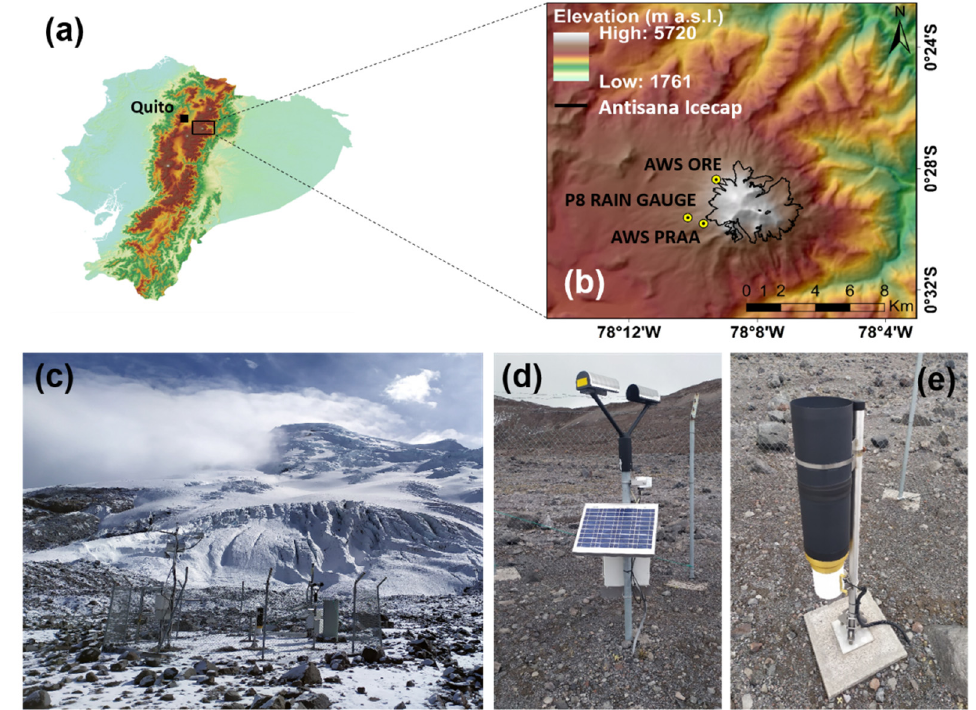
Figure 1. ( a ) Map of study area respect to city of Quito and the Ecuadorian Andean mountain range. ( b ) Topography of Antisana massif and locations of AWS PRAA, AWS ORE and P8 rain gauge. The Antisana icecap outline was taken from Basantes-Serrano [22]. The elevation was presented in meters above sea level (m a.s.l). ( c ) Photography of AWS PRAA. ( d ) Disdrometer Parsivel OTT 2 . ( e ) Pluviograph Texas electronics TE 525WS with rubber funnel used as a reference for liquid precipitation under low wind speed conditions.